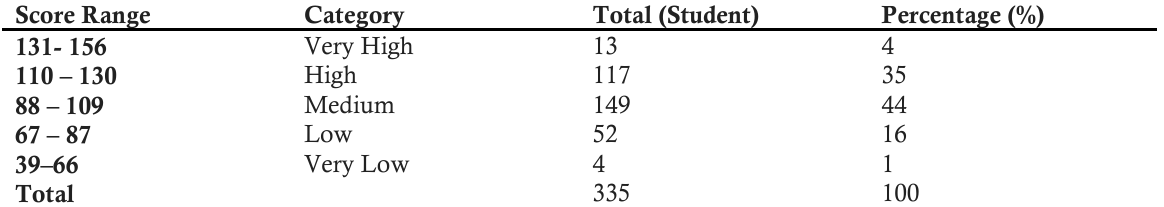
Table 1. Classification of Student Emotional Intelligence Scores